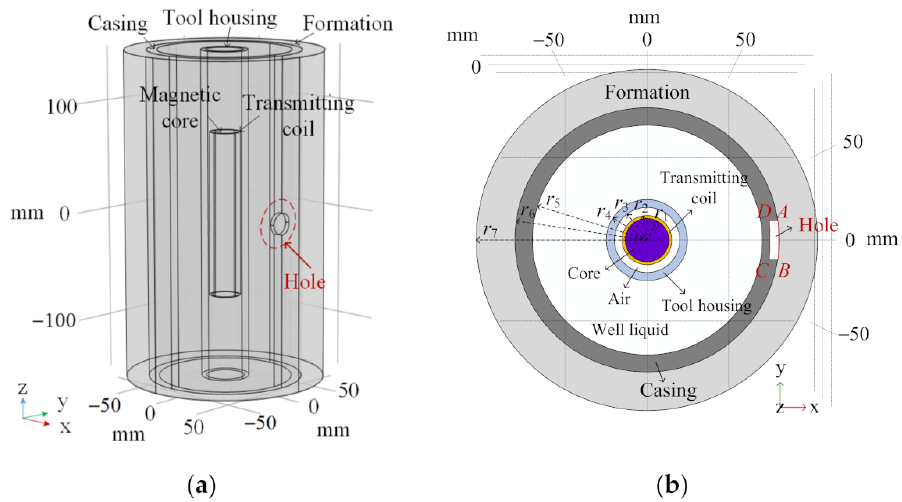
Figure 1. Downhole pulsed eddy current (PEC) system with a hole defect: ( a ) Schematic of a PEC model; ( b ) cross-section at z =